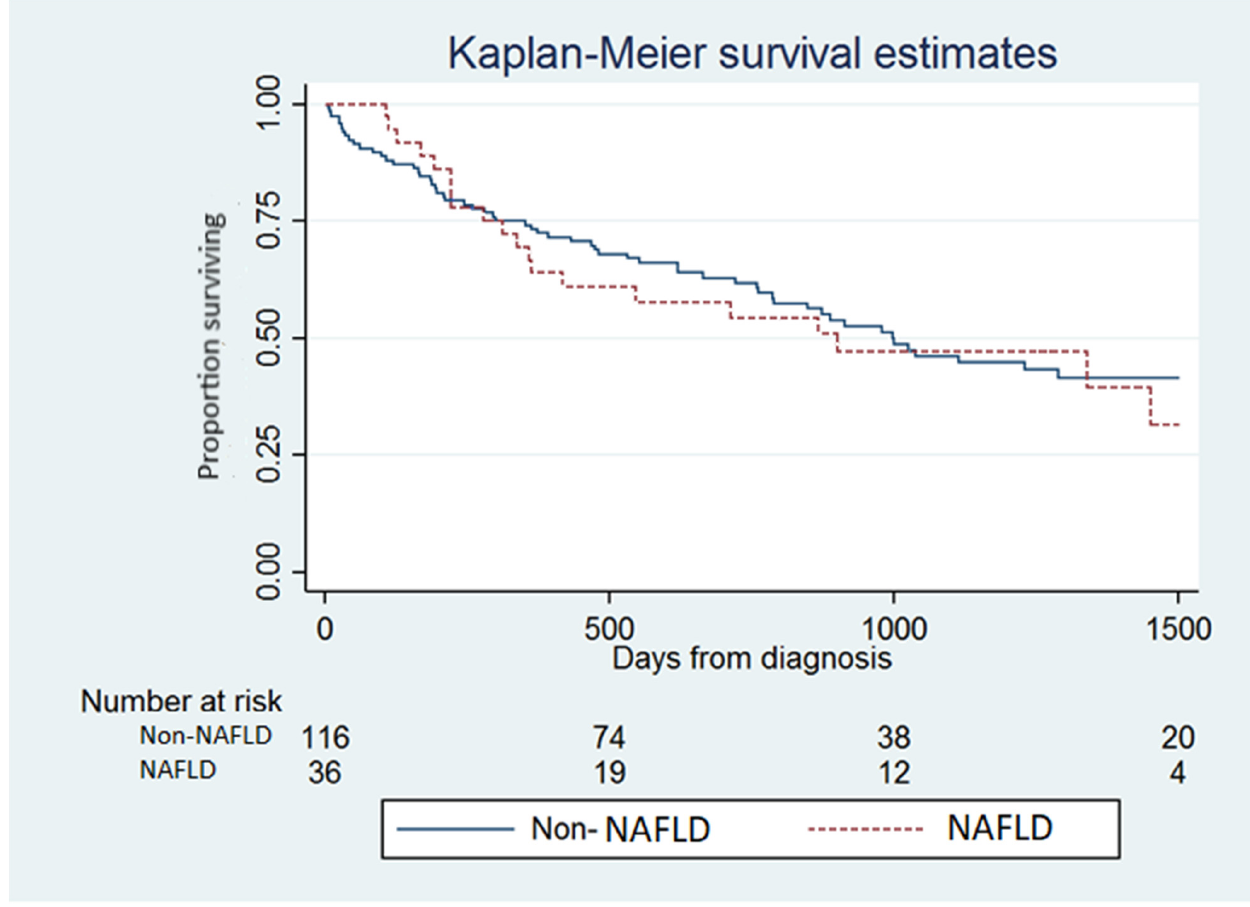
Figure 2. Unadjusted Kaplan–Meier survival curves of patients with NAFLD vs. patients with non ‐ NAFLD. NAFLD: Non ‐ alcoholic fatty liver disease.